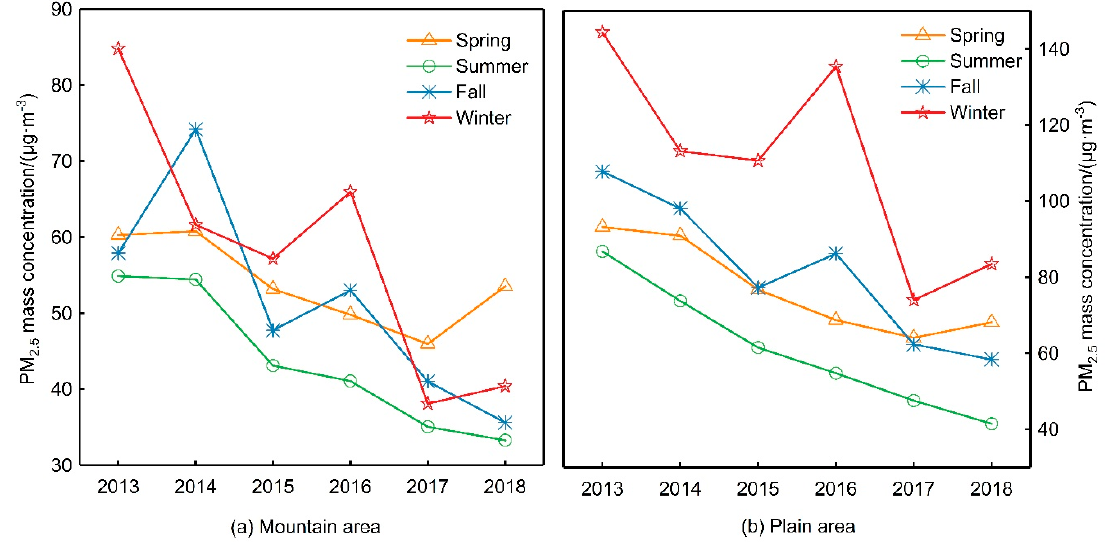
Figure 2. Seasonal variation of PM 2.5 mass concentrations of BTH from 2013–2018.